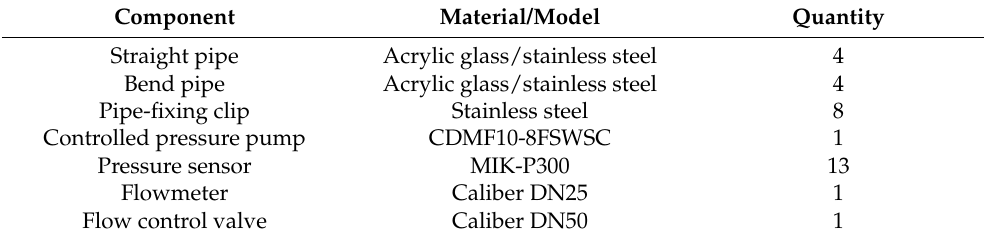
Table 2. Piping laboratory equipment.